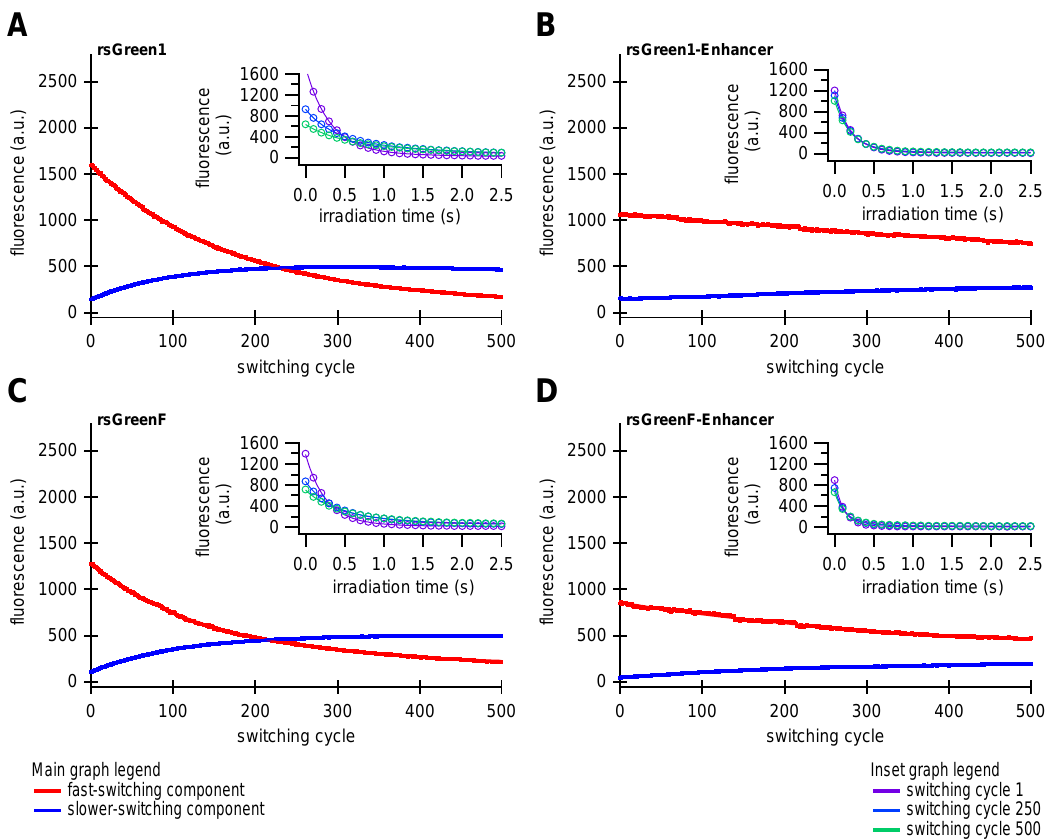
Figure 5. Global fits describing a two-species model for photoswitching in HeLa cells. Contribution of the two switching species of ( A ) rsGreen1, ( B ) rsGreen1-Enhancer, ( C ) rsGreenF, ( D ) rsGreenF-Enhancer and their respective fits (Appendix B). Red curves represent the fast-switching species A, blue curves the slower-switching species B. Inset: single off-switching decays and their respective fits for switching cycles 1 (purple), 250 (light blue) and 500